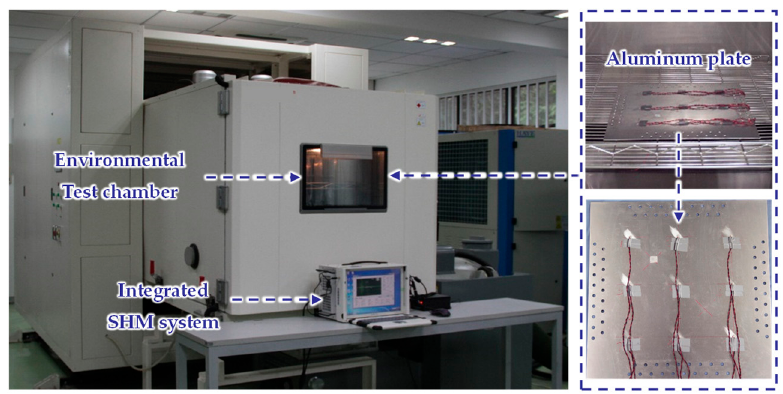
Figure 8. Experimental system of temperature influence on LW.